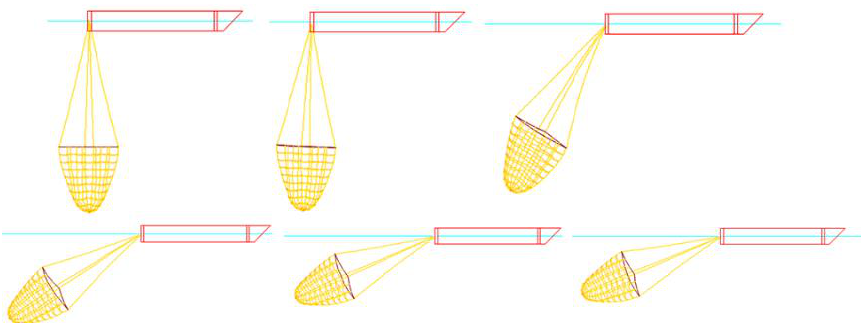
Figure 15. Shape changes of rigid truss trawl in straight-line towing at v = 3 m/s.